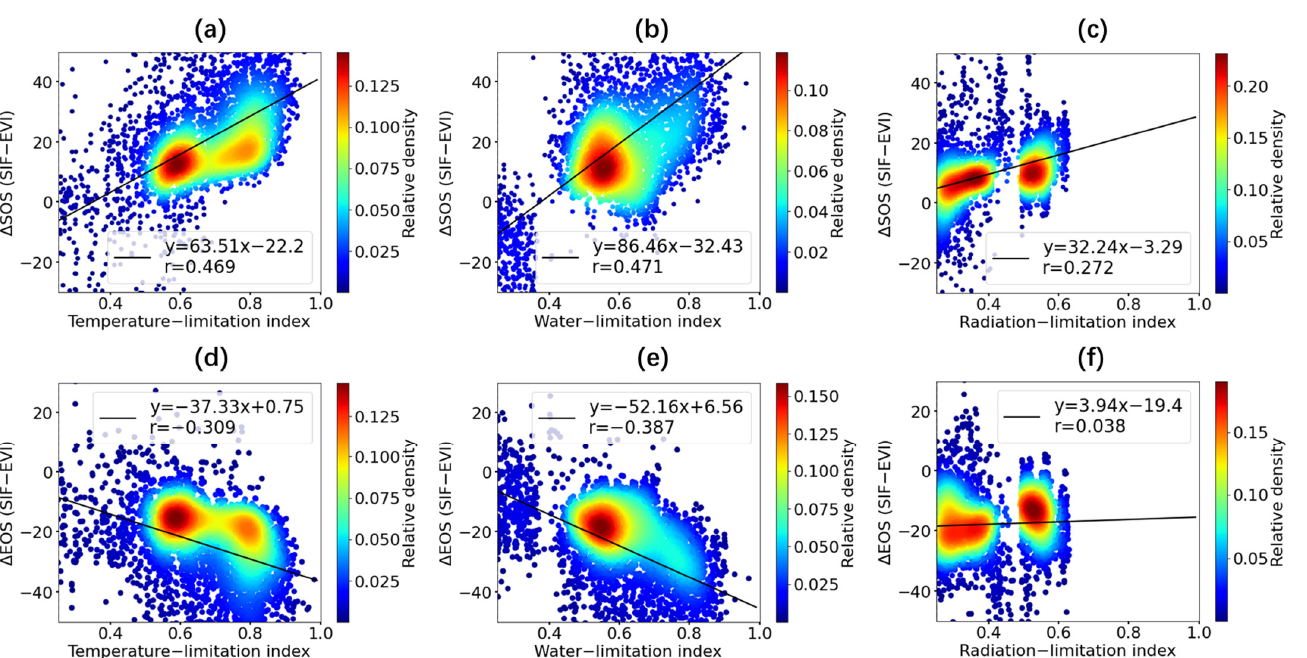
Figure 3. The differences in SOS ( a ) or EOS ( b ) derived from SIF and EVI among different climatic limitation areas.